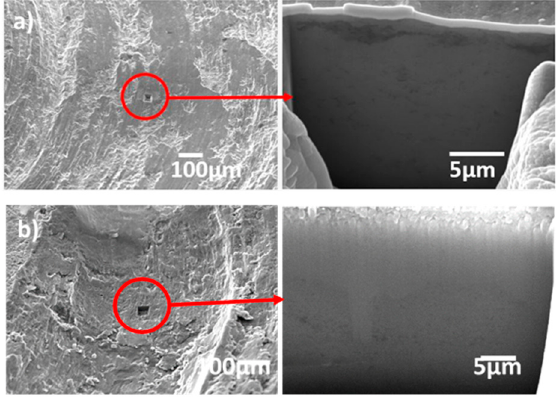
Figure 1. FIB image of trench on the wear track and subsurface of Al-2 vol % GNP after ( a ) RT Test and ( b ) 200 °C Test.